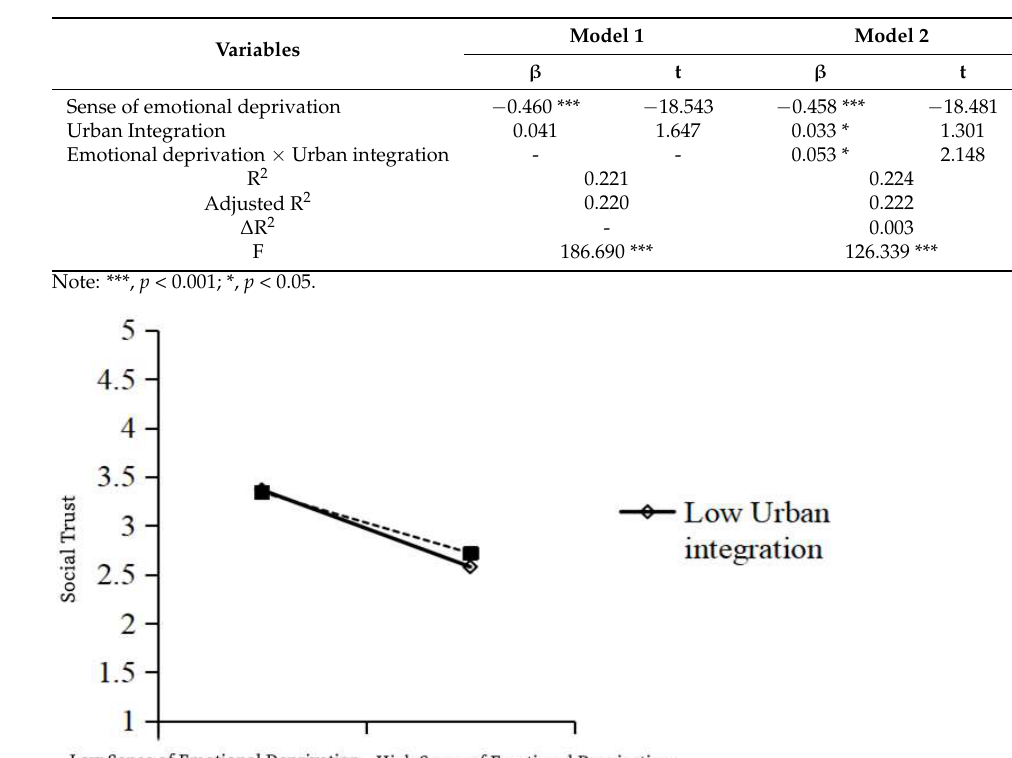
Figure 2. Graph of the moderating effect of urban integration in the relationship between the sense of social deprivation and social trust. Table 12. Test of the moderating effect of urban integration on the relationship between emotional deprivation and social trust.